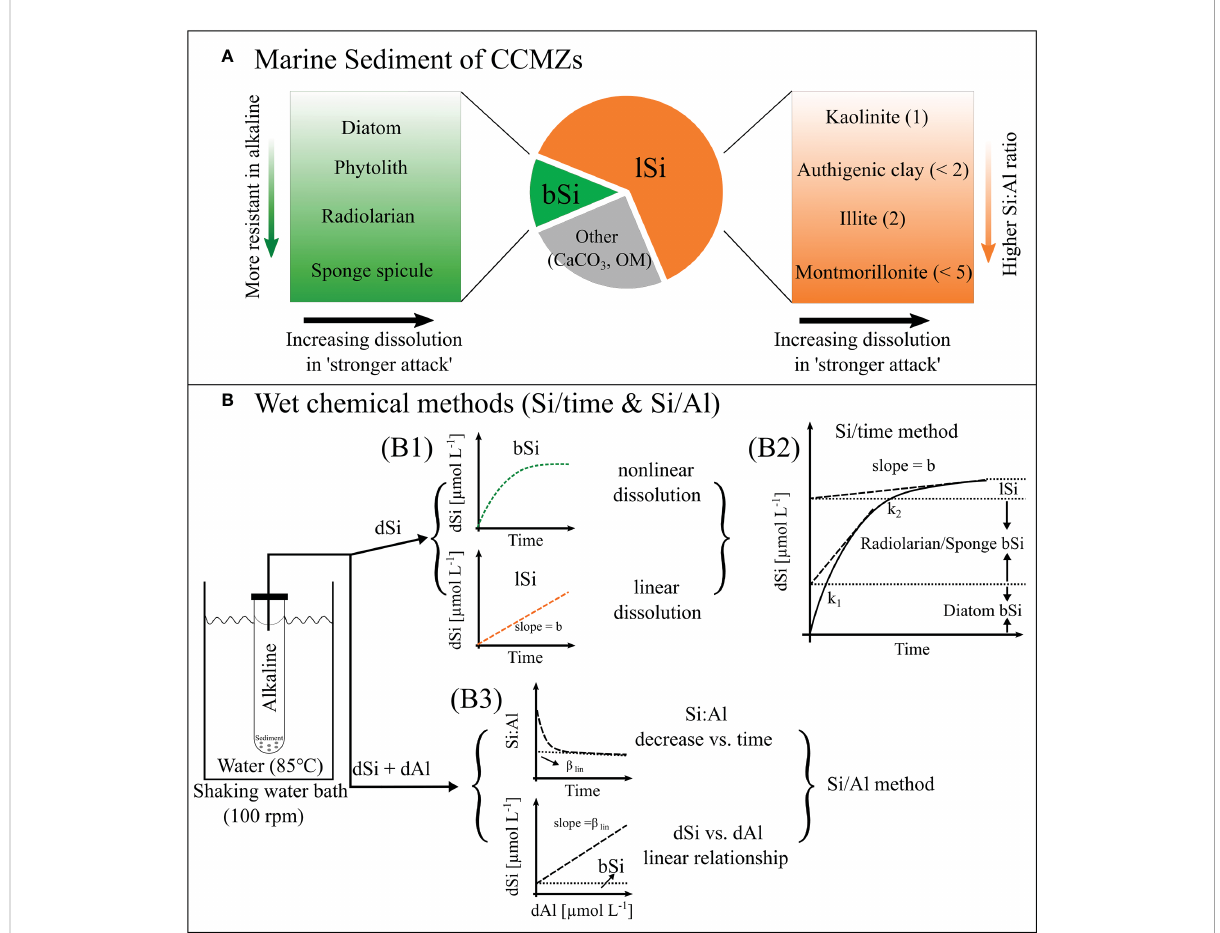
FIGURE 1 The schematic diagram shows the: (A) components in the sediment of CCMZs and (B) Wet chemical methods (B1: Si/time method; B2: Si/Al method). (A) shows the types of bSi in sediment and their dissolution capability: diatom< phytolith< radiolarian< sponge spicule (Mortlock and Froelich, 1989; Müller and Schneider, 1993; Meunier et al., 2014) and types of lSi in sediment and their Si:Al ratio: authigenic clay: Si:Al< 2 (Mackin, 1989; Michalopoulos and Aller, 1995); Kaolinite: Si:Al = 1, Illite: Si:Al = 2, Montmorillonite: Si:Al< 5 (Koning et al., 2002). The ‘ stronger attack ’ represents high alkaline concentration/pH, longer extraction time and sample pretreatment with acid (e.g. HCl) and/or oxidizing agents (e.g. H 2 O 2 ). (B) shows the alkaline digestion (85°C) of bSi and correction of lSi using the Si/time method (B1) modi fi ed from DeMaster (1981), the Si/time method (B2) modi fi ed from Conley and Schelske (2001) and the Si/Al method (B3) modi fi ed from Kamatani and Oku (2000). The Si/time method (B1 and B2) assumes the bSi dissolves non-linearly through time whereas the lSi dissolves linearly (the slope equals to dissolution rate ‘ b ’ ) through time, the different types of bSi (diatom, radiolarian and sponge spicules) can be quanti fi ed based on their dissolution rate ( k1 , and k2 ). The Si/Al method (B3) assumes that the ratio of alkaline extractable Si vs. Al is constant, and the alkaline extractable Al is mainly lSi origin, the Si:Al ratio of bSi is higher (> 5) than lSi (< 5) (Koning et al., 2002). The Si: Al vs. time plot shows a decrease of Si:Al ratios to constant value after a complete digestion of